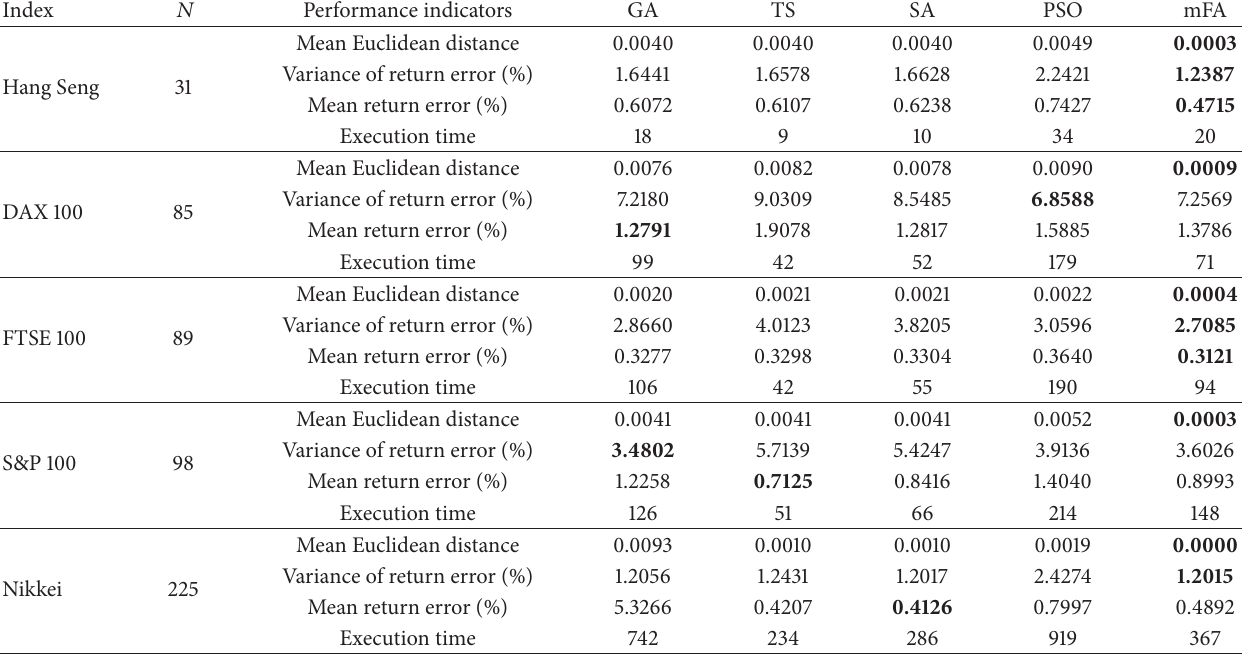
Table 5: Experimental results for five